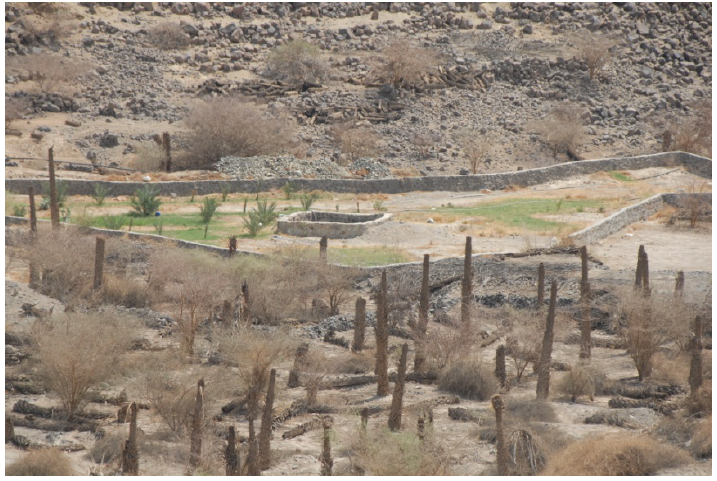
Figure 1. Large-diameter abandoned well at the center and a dead date palm plantation in western Wadi Qidayd, Saudi Arabia. Aquifer depletion has caused the large-scale failure of small farms and abandonment of some villages as shown by the dead date